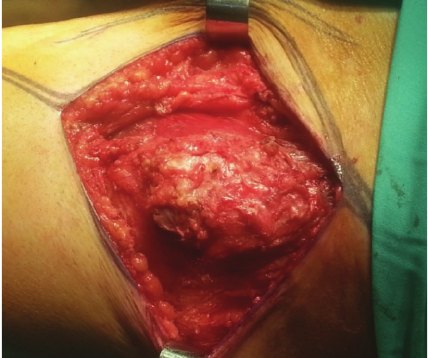
Figure 1: Macroscopic appearance of the metastases from bladder cancer to left sartorius muscle.